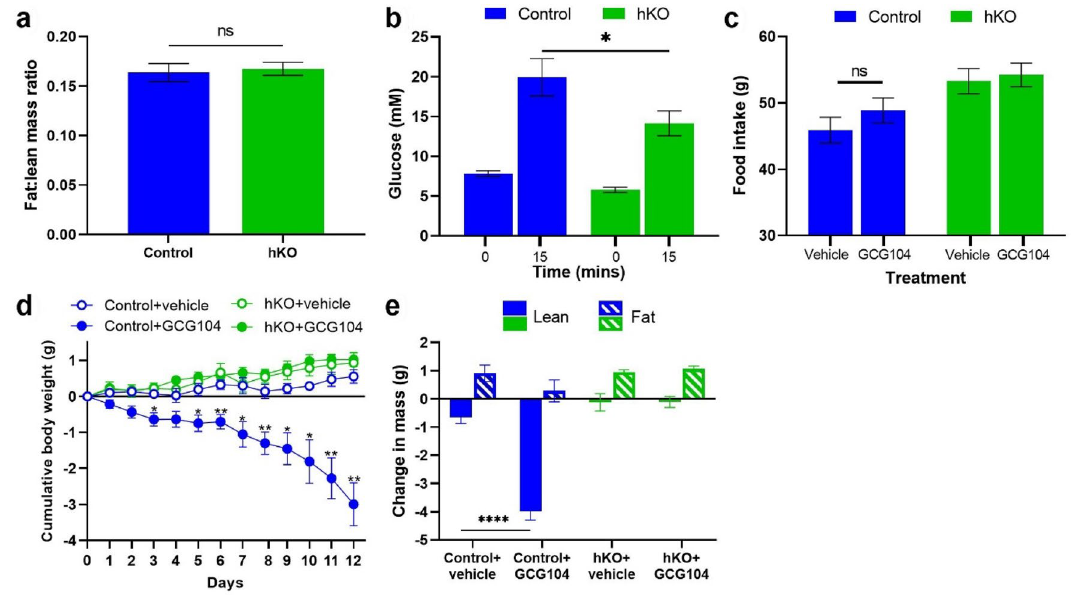
Figure 3. GCG104 reduces body weight in mice by hepatocyte signalling. ( a ) Fat:lean mass ratio of the hKO mice and controls (n = 13 per group; unpaired t test). ( b ) Baseline and 15-min glucose response readings for an IPGTT in the hKO (n = 8) and control mice (n = 5; two-way ANOVA with Sidak post hoc test). ( c ) 12-day cumulative food intake for control and hKO animals injected daily with vehicle (n = 4 and 7, respectively) or 10 nmol/kg GCG104 (n = 5 and 7, respectively; two-way ANOVA with Sidak post hoc test). ( d ) 12-day cumulative body weight change in control and hKO animals injected daily with vehicle (n = 4 and 7, respectively) or 10 nmol/kg GCG104 (n = 5 and 7, respectively; repeated measures 2-way ANOVA with Tukey’s post hoc test). ( e ) 12-day change in body composition for control and hKO animals dosed with vehicle (n = 4 and 7, respectively) or 10 nmol/kg GCG104 (n = 5 and 7, respectively); two-way ANOVA with Sidak post hoc test. p values indicated by * p < 0.05, ** p < 0.01, **** p < 0.0001. All data presented as mean ±